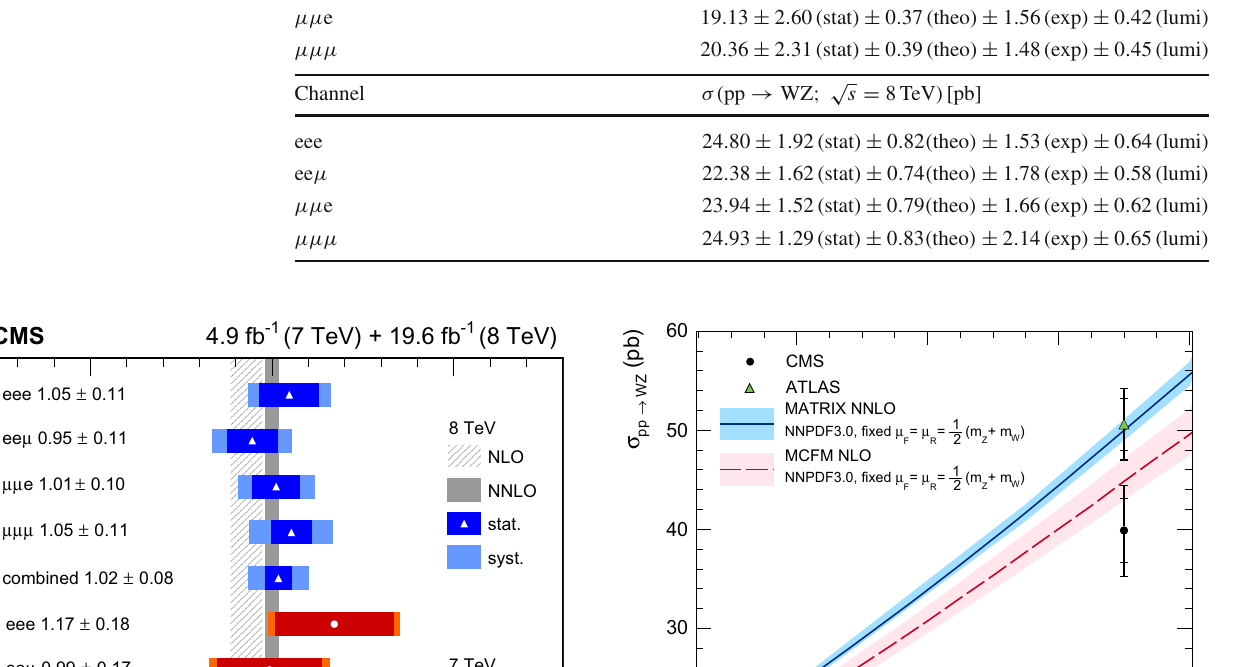
section in the four leptonic √ s = 7 and 8TeV channels at